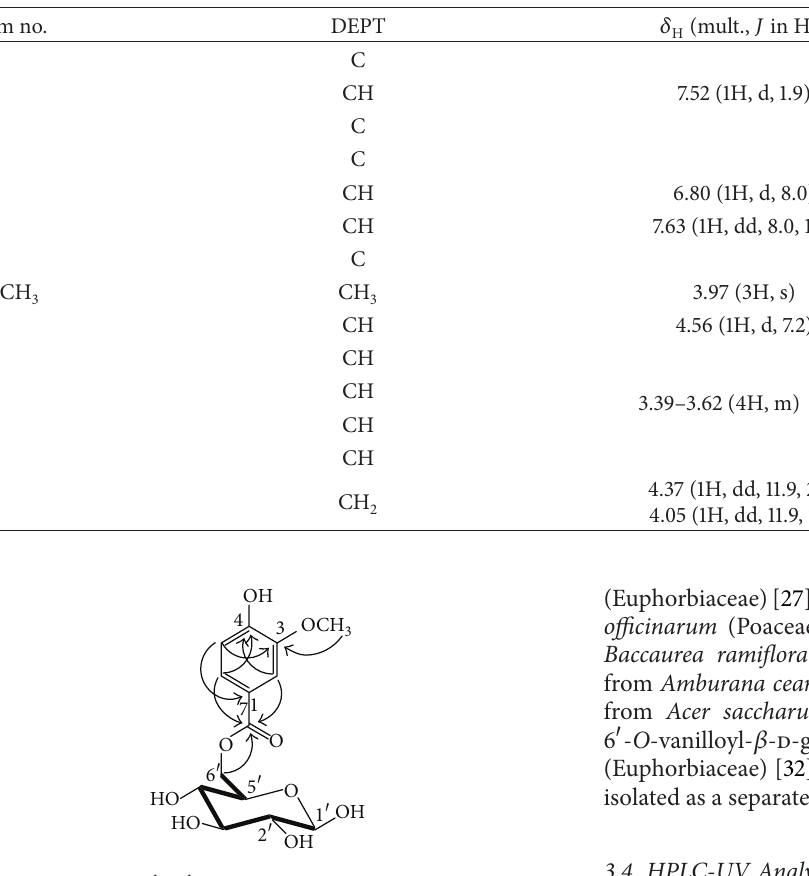
Table 2: 1 H-NMR and 13 C-NMR data of compound 6 .